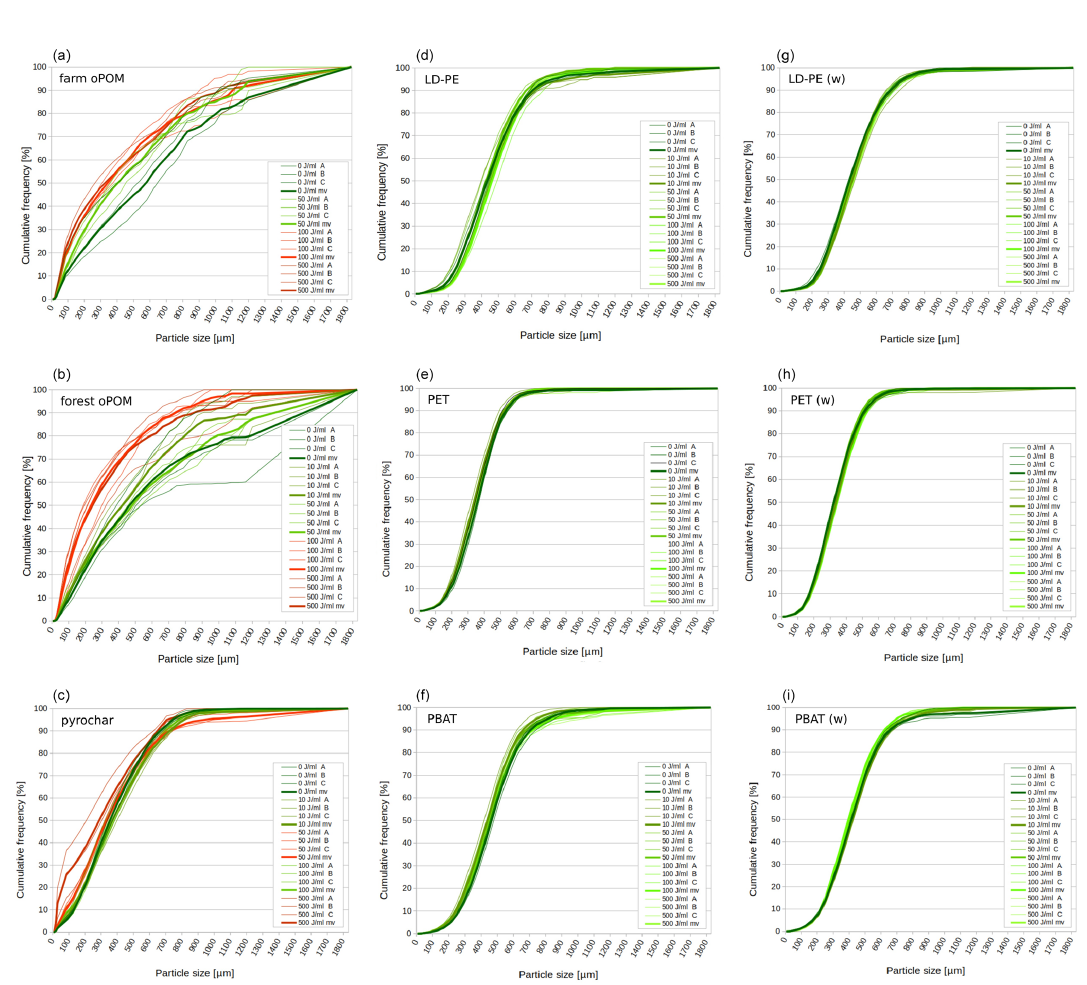
Figure 1. Particle size distribution of natural POM (a–c) and microplastics (d–i) after ultrasonic treatment with 0, 10, 50, 100 and 500JmL − 1 ( n = 3: A, B, C). Green graphs are similar to the 0JmL − 1 treatment ( p ≥ 0 . 05 or comminution factor ≤ 1.1), red graphs significantly different by p < 0 . 05 and comminution factor > 1.1. Bold lines represent mean values (mv). The (w) marks weathered